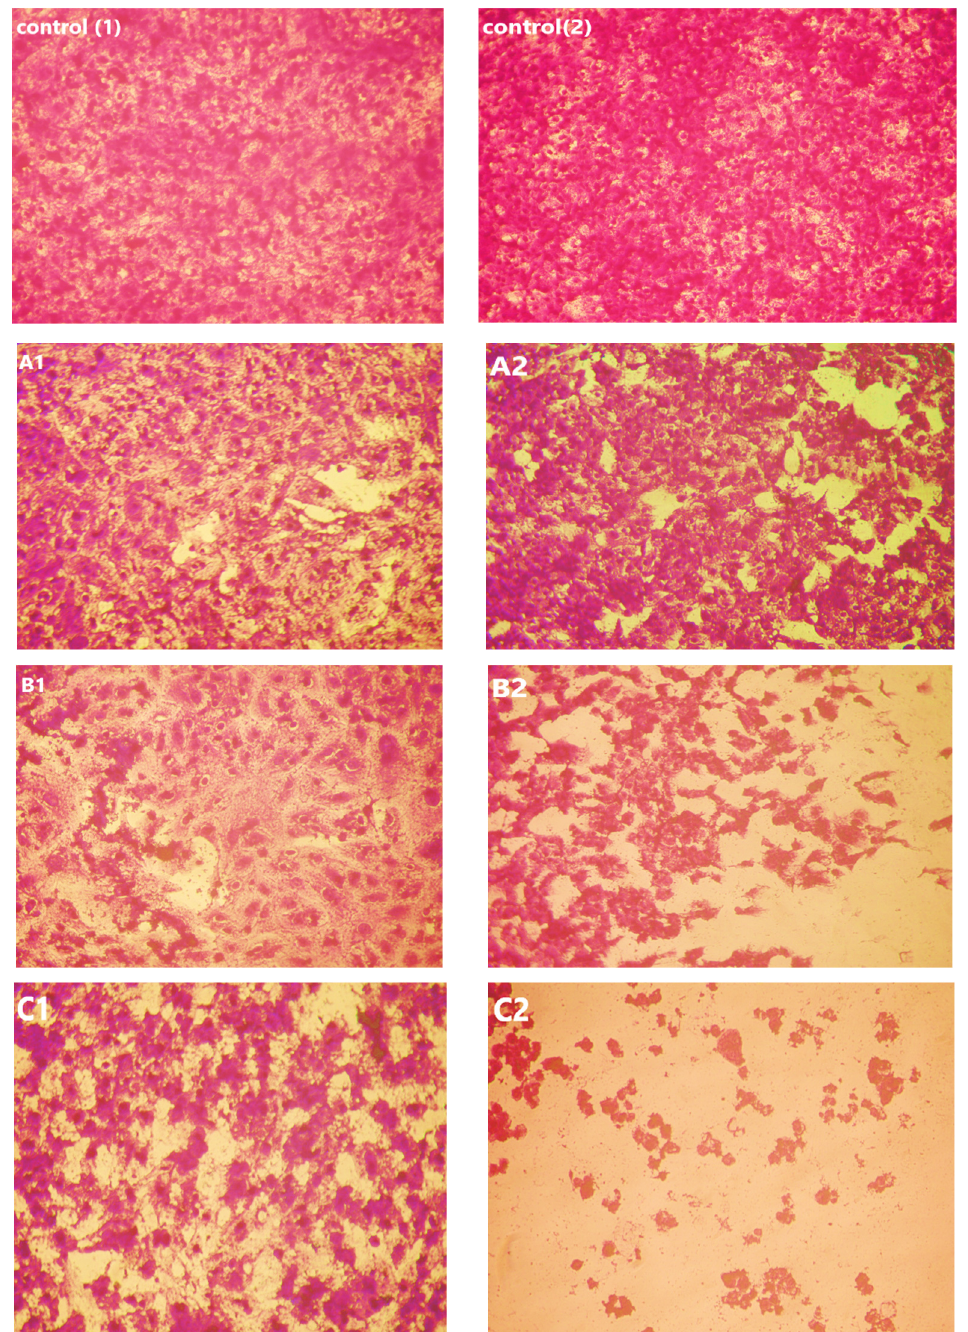
Figure 10. The cytotoxicity of USeNPS against mammalian cells from African green monkey kidney (Vero) with 50% cell cytotoxic concentration (CC 50 ) = 331.76 ± 4.79 µg/mL.